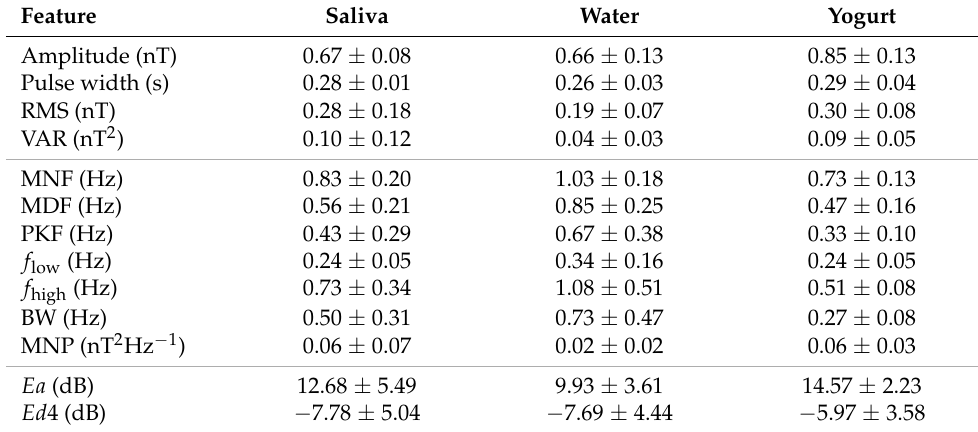
Table 3. Features grouped per swallowing task for the single actuator experiment. Values provided in mean standard deviation. Domains are separated by grey lines. ±